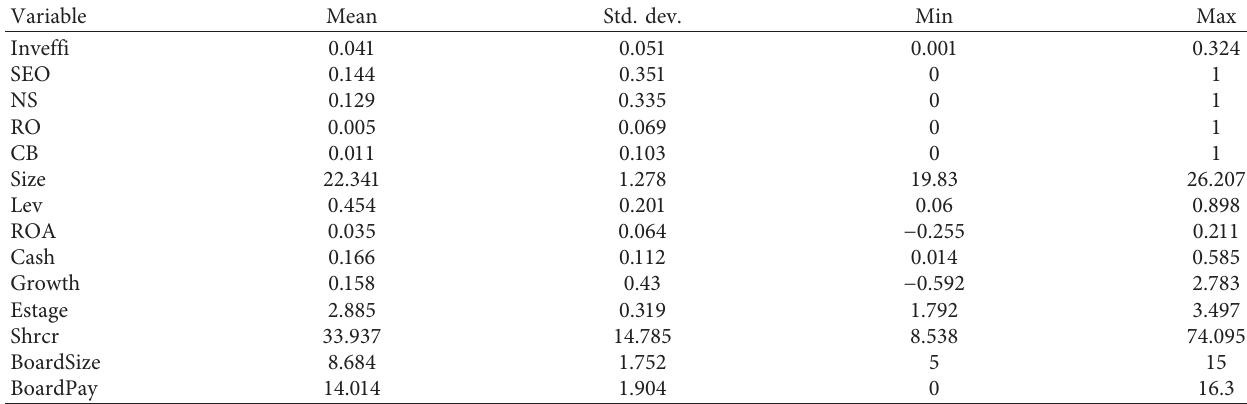
Table 2: Descriptive statistics of model